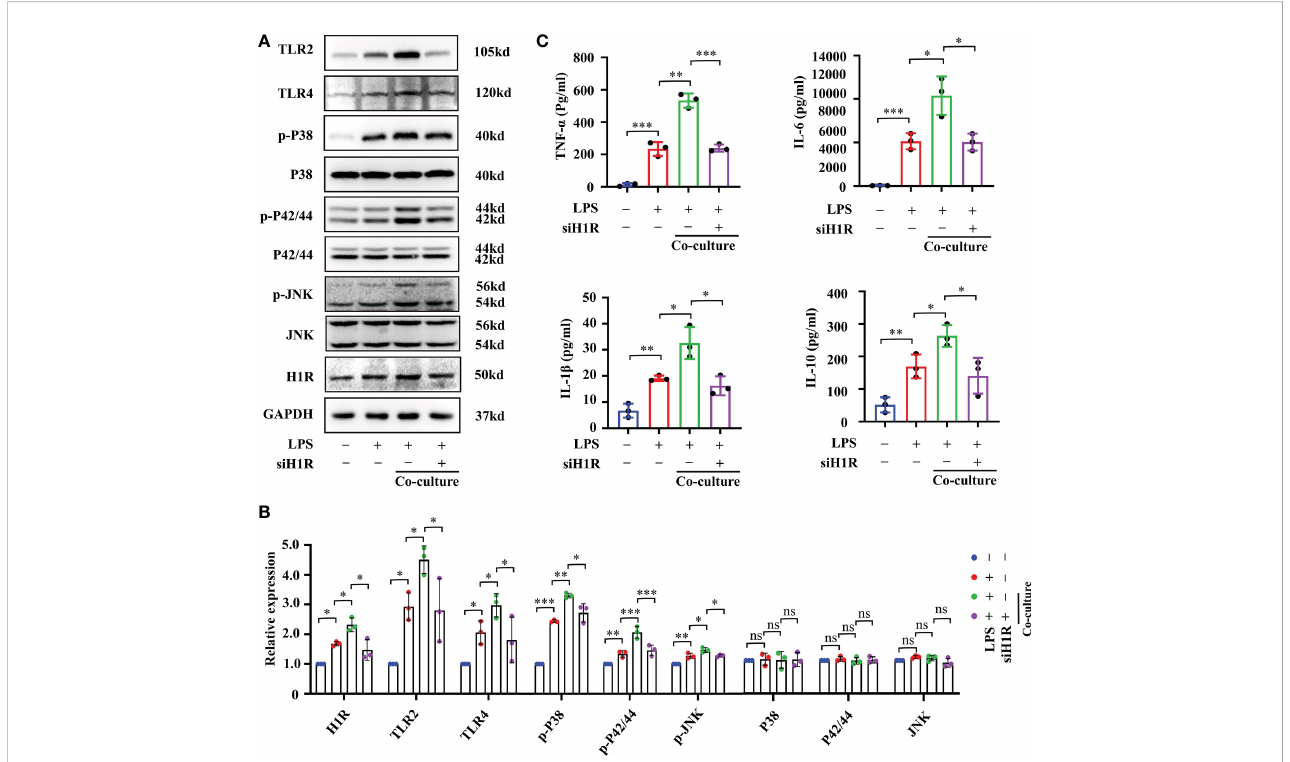
FIGURE 8 Interfering H1R expression in bEnd.3 cells decreased cell in fl ammation response. (A) Expression levels of TLR2/4-MAPK signaling pathway proteins were checked by Western blot after bEnd.3 cells were transfected with H1R siRNA (n=3). (B) Expression levels of TLR2/4-MAPK signaling pathway proteins were quanti fi ed and normalized to GAPDH levels after bEnd.3 cells were transfected with H1R siRNA (n=3). (C) Abundance of TNF- a , IL-6, IL-1 b and IL- 10 in medium supernatant was examined by ELISA after bEnd.3 cells were transfected with H1R siRNA (n=3). H1R: histamine 1 receptor, TLR: Toll-like receptor, MAPK: Mitogen-activated protein kinases. (ns, no signi fi cance, *p <0.05, ** p <0.01, *** p